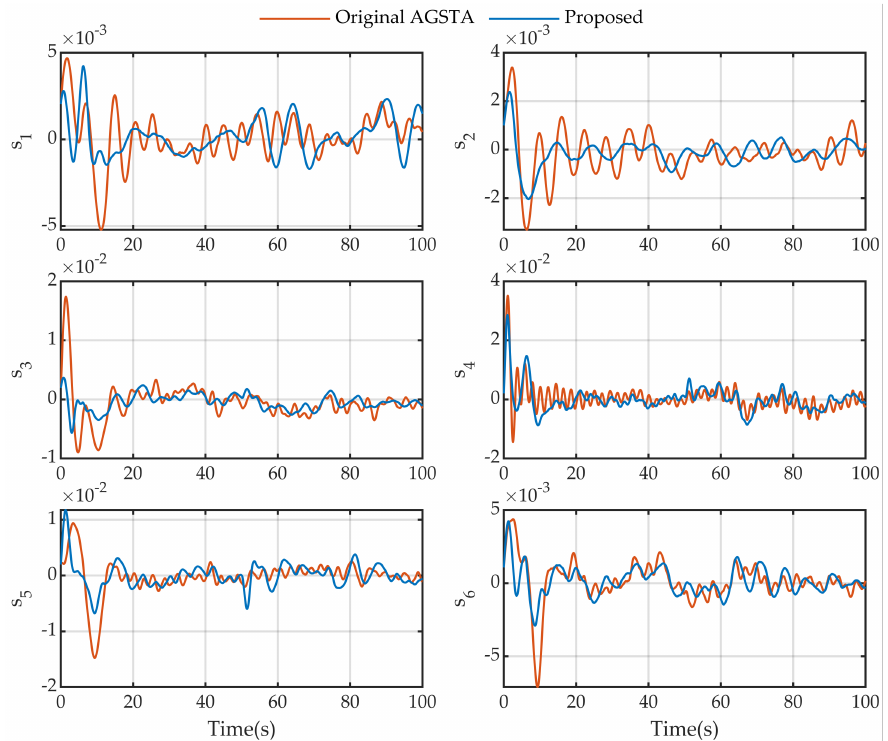
Figure 8. Time trajectories of sliding variables during station-keeping